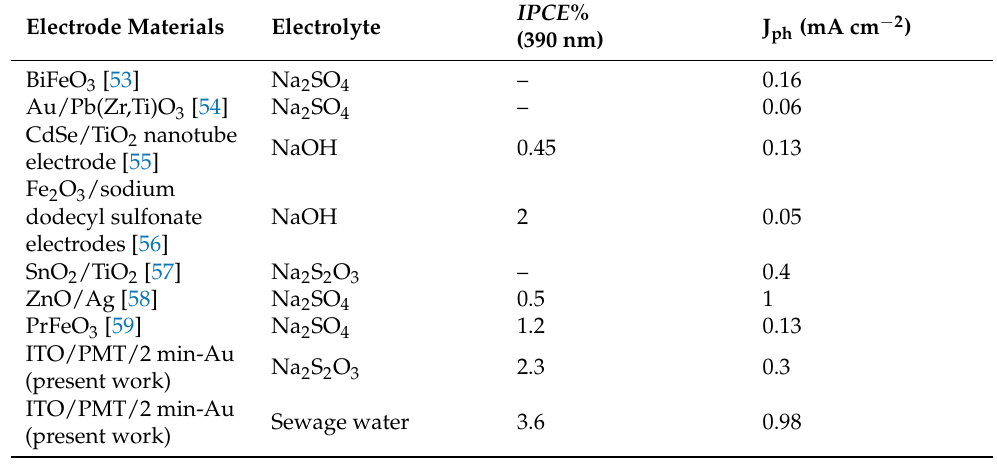
Table 4. IPCE and J ph values of the present work compared with the previous